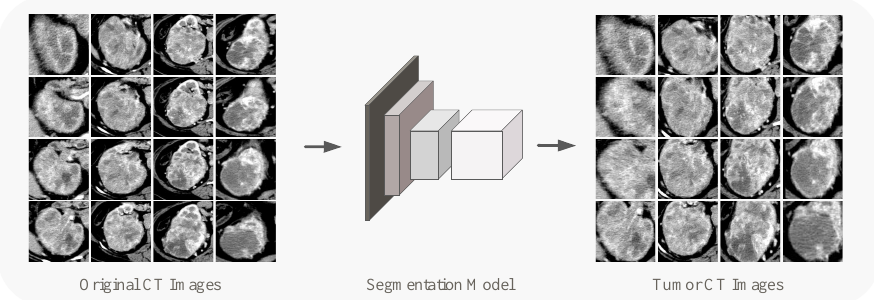
Figure 1. Segmentation model concentrates the CT image’s content on the